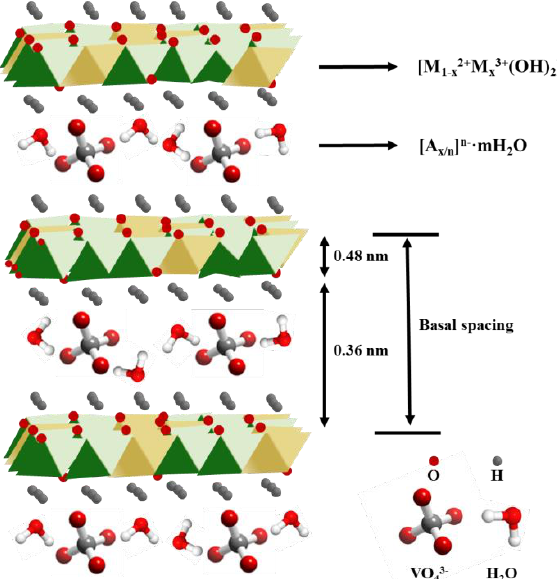
Figure 7. Schematic structure of ZnFe–VO 4 -LDH. Adapted from Ref. [59], Copyright 2018, Royal Society of Chemistry.